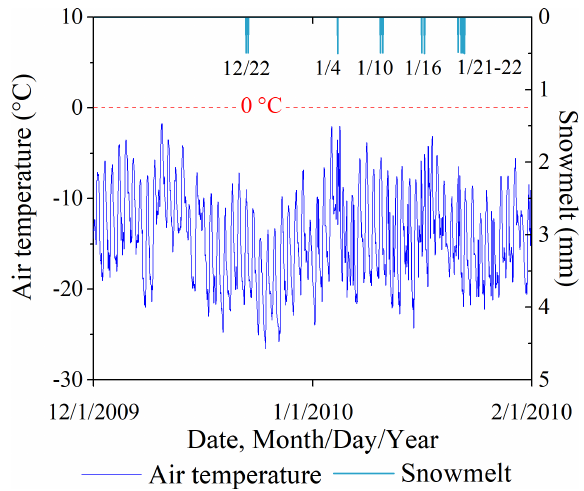
Figure 3. Unusual warm air temperature in January 2010, pre- sumably related to overestimation of modeled soil temperature that month, and simulated hourly snowmelt, also influenced by air tem- perature. The dates (month/day) at the top of the figure indicate when the snowmelt events